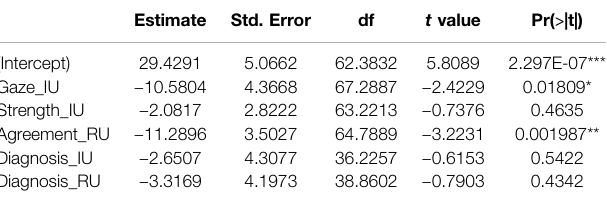
TABLE 4 | Coef fi cient table of the model used to probe the effect of the gazing ratio of the initiating utterance for the speaker (Gazing_Ratio_IU ), the depressiondiagnosisofthe speaker ofthe initiating utterances (Diagnosis_IU) and the speaker of the responsive utterance (Diagnosis_RU), strength of the original initiating utterance (Strength_IU; 0 (cid:1) weak, 1 (cid:1) strong), and agreement of the responsive utterance (Agreement_RU; 0 (cid:1) disagreement, 1 (cid:1) agreement) on howlong(inseconds)ittakesforaresponsetotakeplace.Themarginal R 2 for the model was 0.17 and the conditional R 2 was